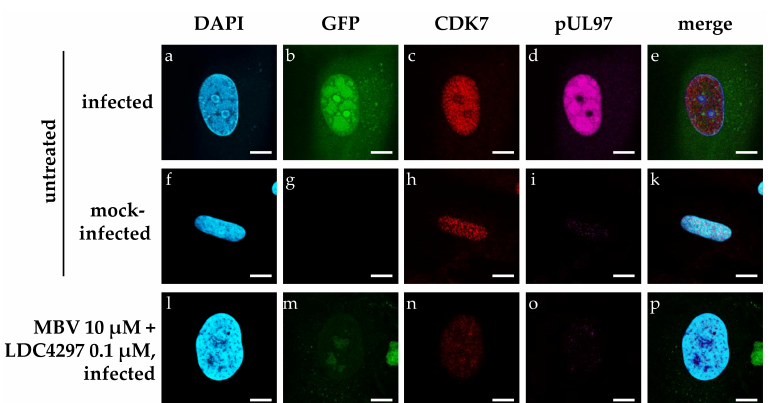
Figure 3. Assessment of the CDK7 and pUL97 intracellular localization and intensity via confocal microscopic analysis in mock-infected ( f – k ), HCMV-infected ( a – e ) and infected cells treated with the combination of MBV + LDC4297 ( l – p ). HFFs were seeded on glass cover slips und used for HCMV AG169-GFP infection (MOI of 1) or remained mock-infected. Cells were treated immediately after infection with the indicated concentrations of compounds for 7 days before fixation and staining. Scale bars represent 10 µ m.